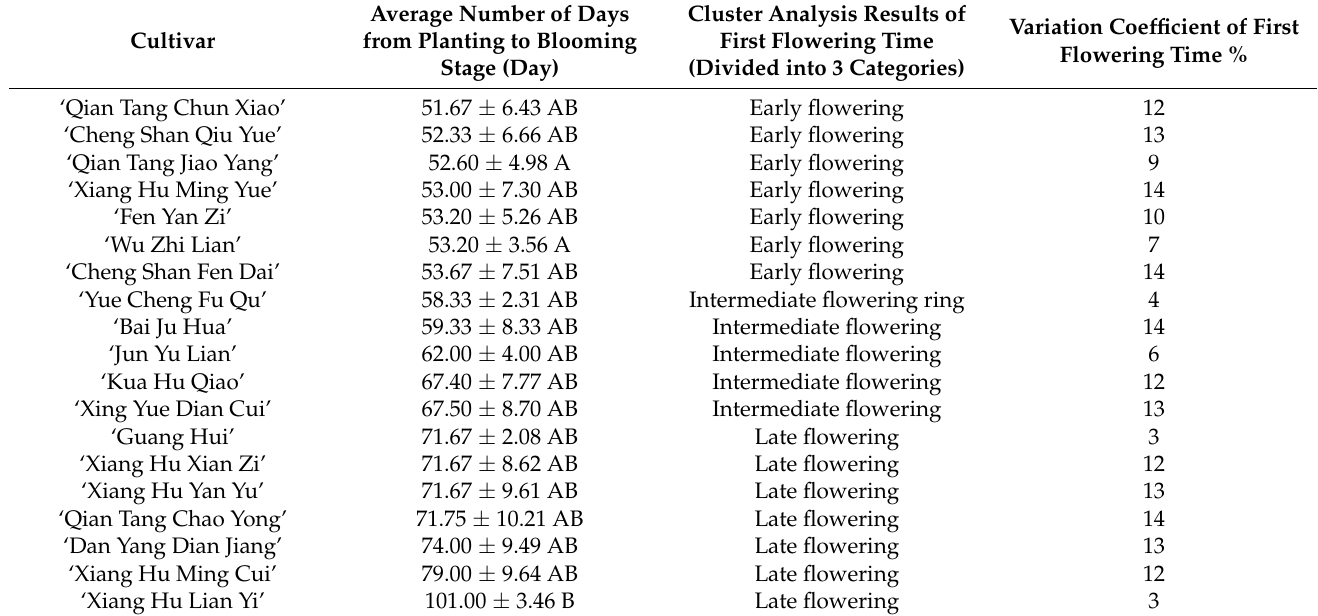
Table 2. Average number of days from planting to blooming stage of 19 Nelumbo nucifera cultivars during 2020.